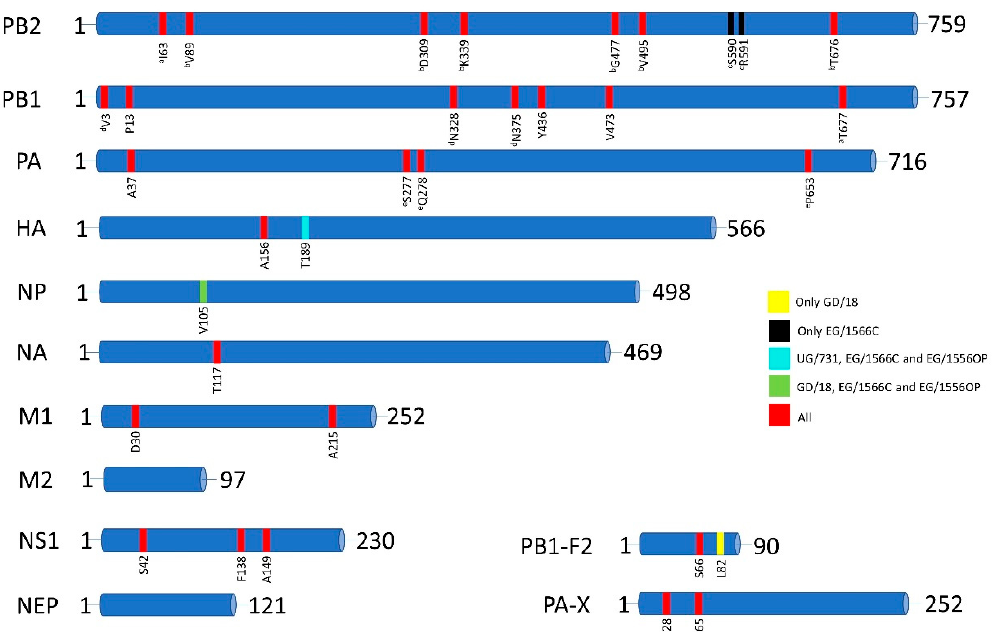
Figure 1. Molecular markers of mammalian adaptation, pathogenicity and antiviral resistance identified in GD/18, EG/1566C, EG/1556OP, and UG/731. Markers identified only in GD/18 are labelled with yellow; only in EG/1566C are labelled with black; in UG/731, EG/1566C and EG/1556OP are labelled with turquoise; in GD/18, EG/1566C, EG/1556OP are labelled with green rectangles on respective proteins. Markers which are conserved in all viruses are labelled with red rectangles. Markers tagged with superscript letters were previously reported to be present together for their corresponding functional outcomes. The numbers on each gene denote the amino acid numbers.